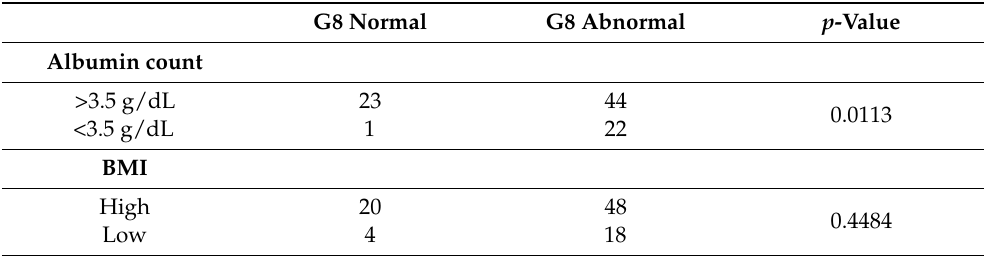
Table 4. Correlation between G8 score and clinicopathological